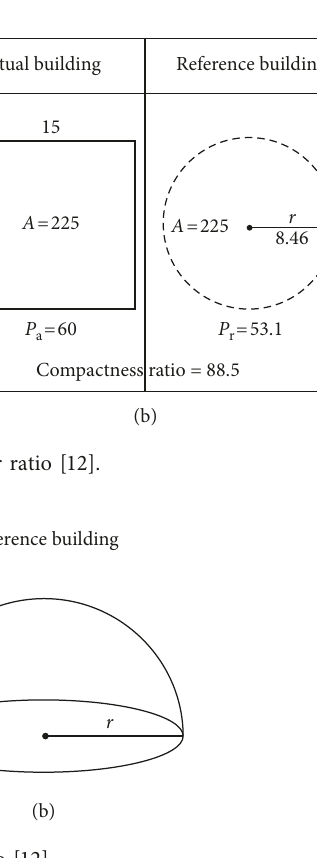
Figure 5: Volume ratio